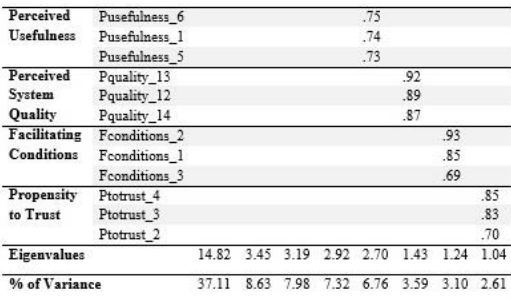
Table 3: The Results of the Regression